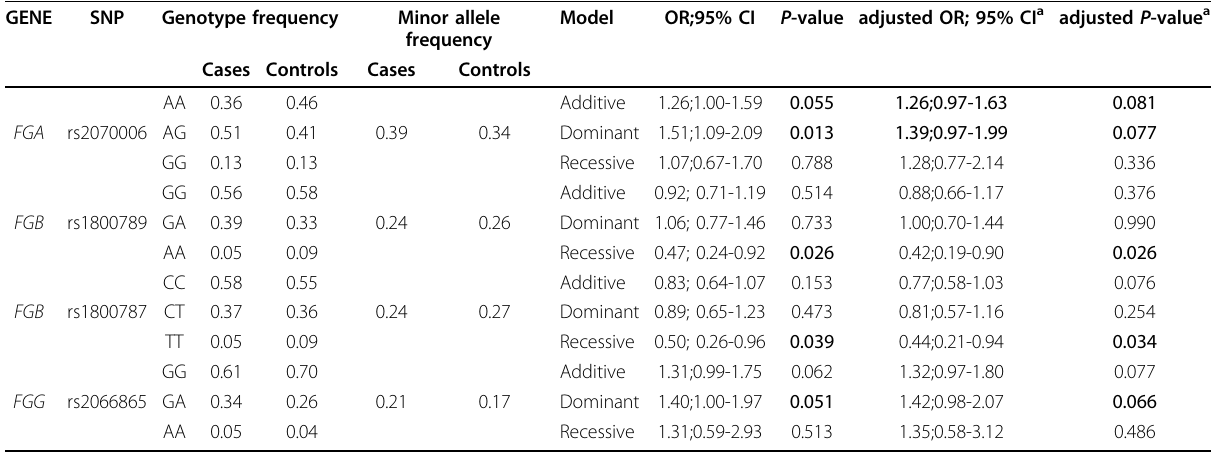
Table 3 Results from logistic regression analysis for SNPs with significant associations before